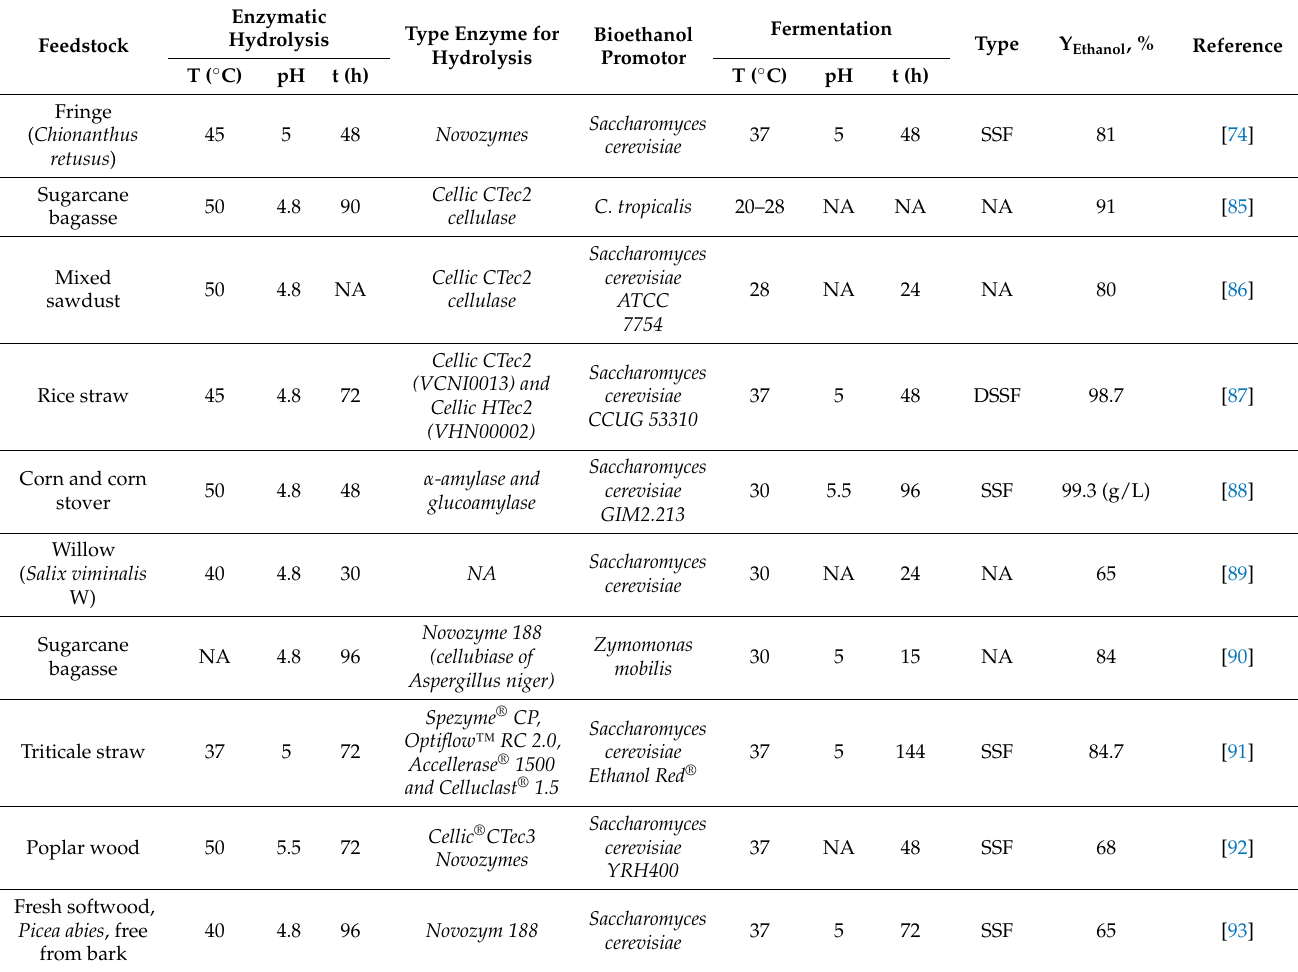
Table 3. Highest-yield bioethanol production with different types of